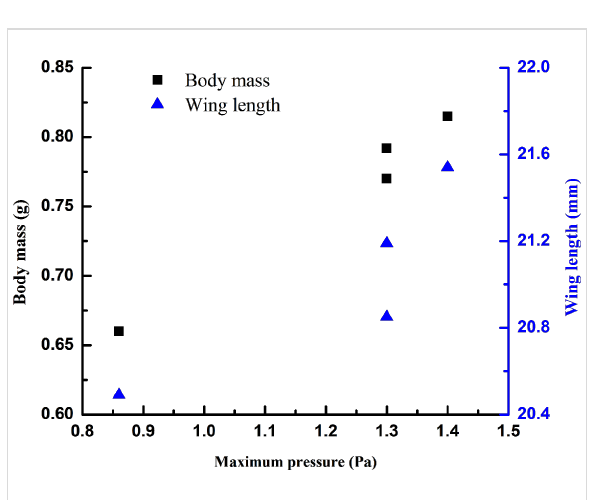
Figure 6: The blood pressure is proportional to the length of the wings and the body mass.